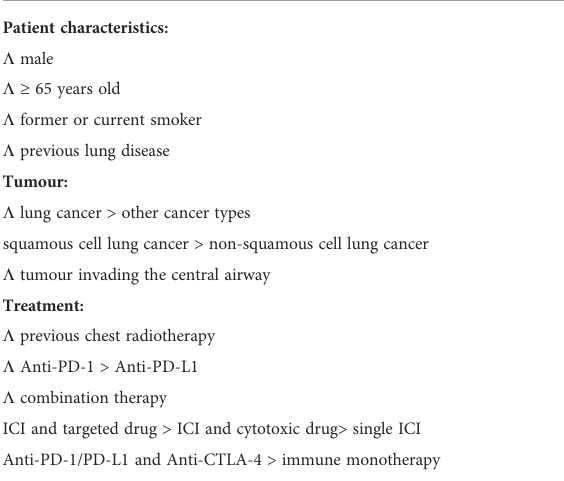
TABLE 2 Risk factors of immune checkpoint inhibitor-related pneumonitis. Patient